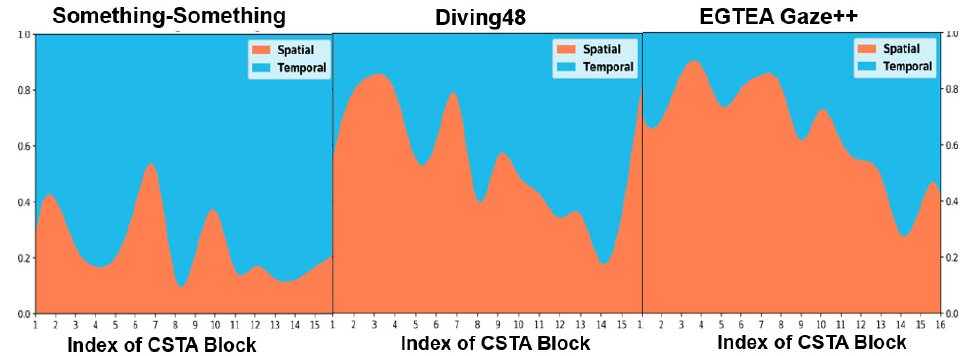
Figure 8. The spatial-temporal features distribution among CSTA blocks.